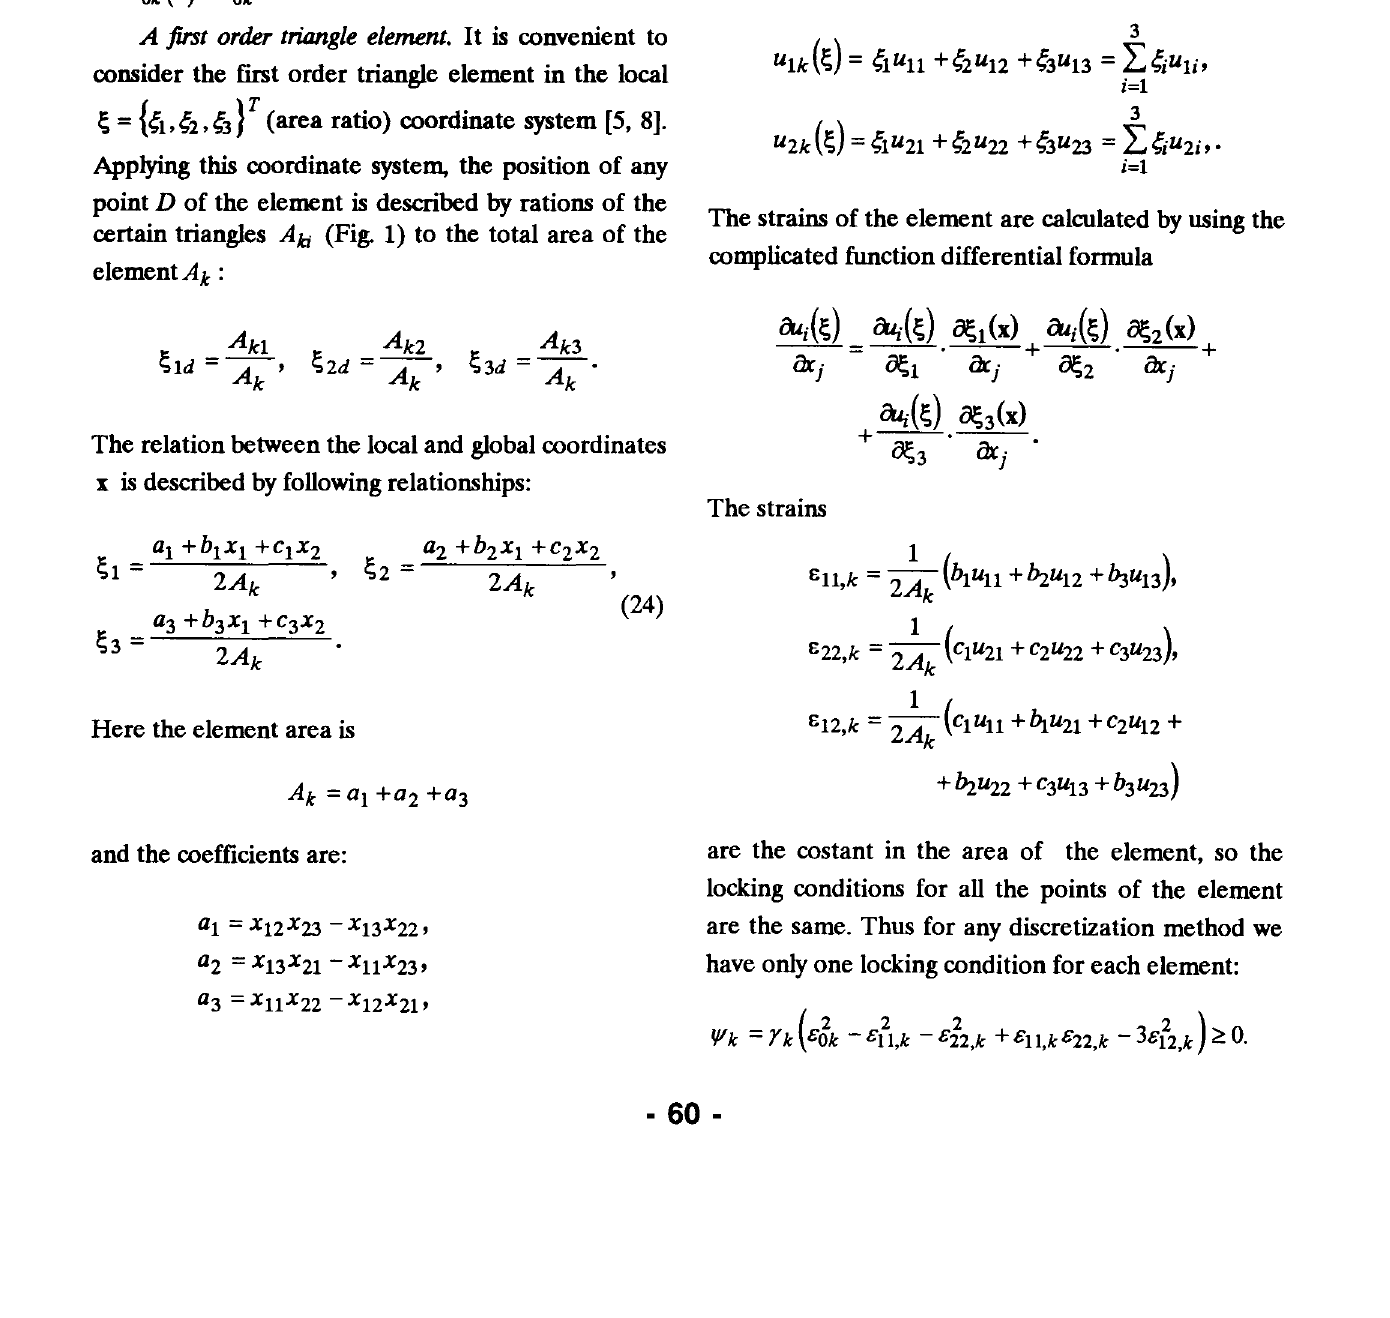
Fig. 1. The first order element The displacements of the finite element are approximated by linear functions